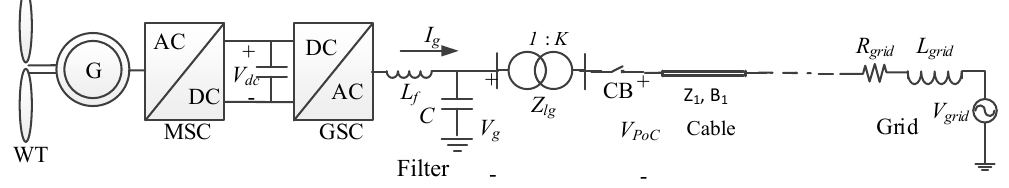
Figure 1. Simplified representation of full-scale converter-based wind turbine connected to the network.